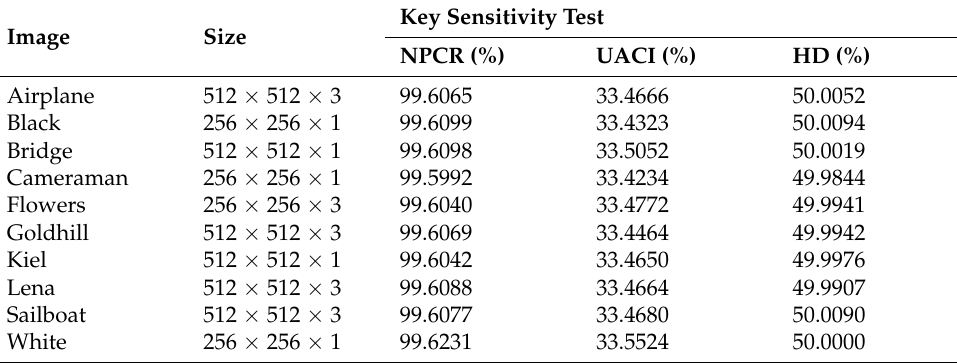
Table 10. Average NPCR, UACI, and HD key sensitivity